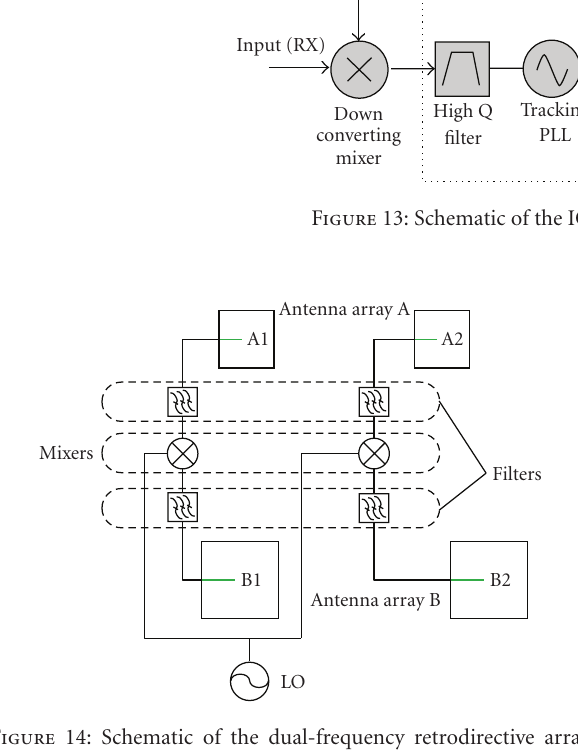
Figure 14: Schematic of the dual-frequency retrodirective array using heterodyne